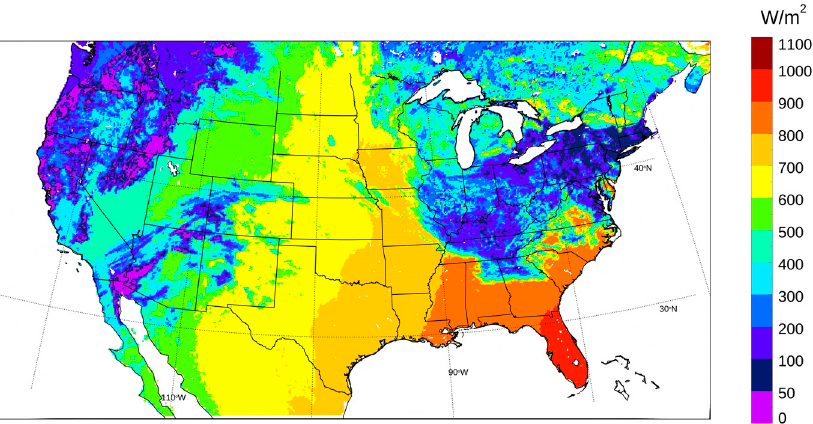
Figure 1. GHI observations from NSRDB on 1530 UTC 16 April 2018 for WRF-Solar computational domain.